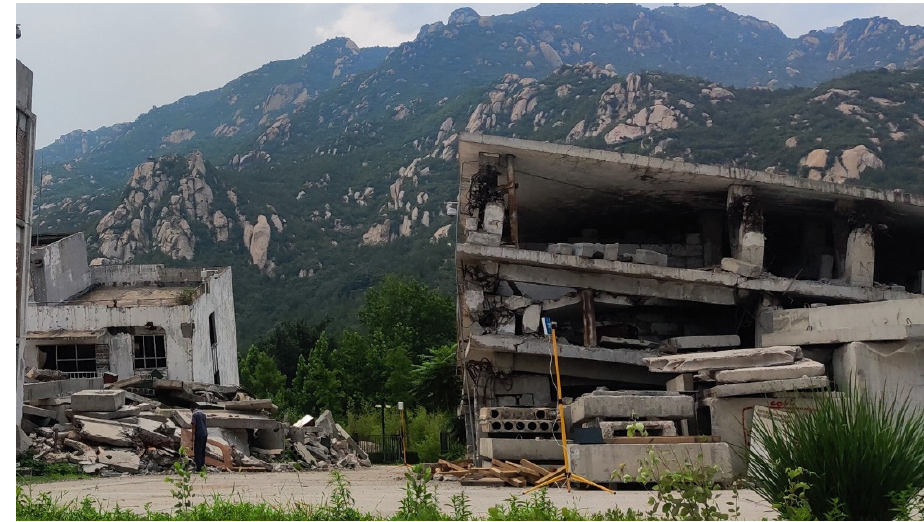
Figure 5. The ruin environment with different standard deviations of the measurement error in different directions.